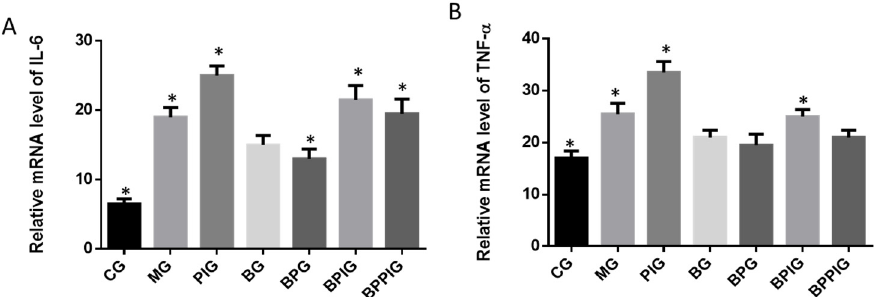
Figure 10 . Real ‐ time quantitative RT ‐ PCR analysis of the mRNA levels of inflammatory cytokines: ( A ) relative mRNA levels of IL ‐ 6; and ( B ) relative mRNA levels of TNF ‐ α . Five liver samples were analyzed in each group. All data are presented as mean value ± S.D. * p < 0.05 via a blueberry juice group BG.